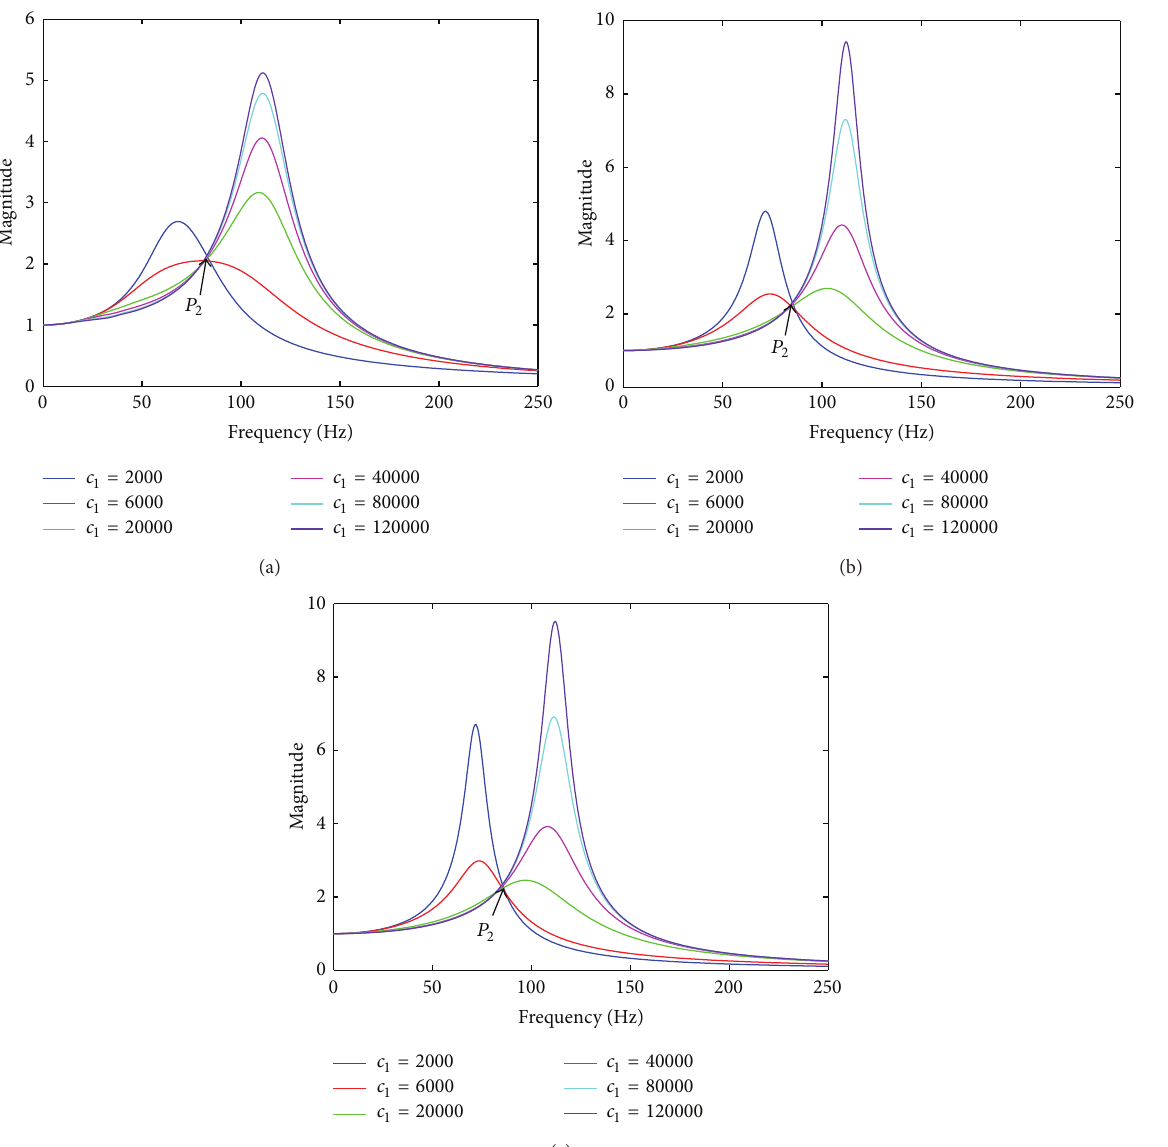
Figure 21: Absolute displacement transmissibility curves of CM under 5.07 mm FDE cases. (a) 𝑛 1 = 1.5 ; (b) 𝑛 1 = 1 ; (c) 𝑛 1 = 0.85 .